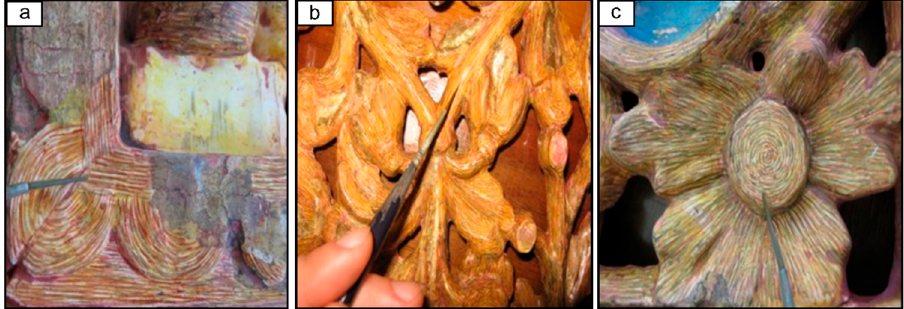
Figure 16. Details of the final gilding reintegration in the tratteggio technique: ( a – c ) details.